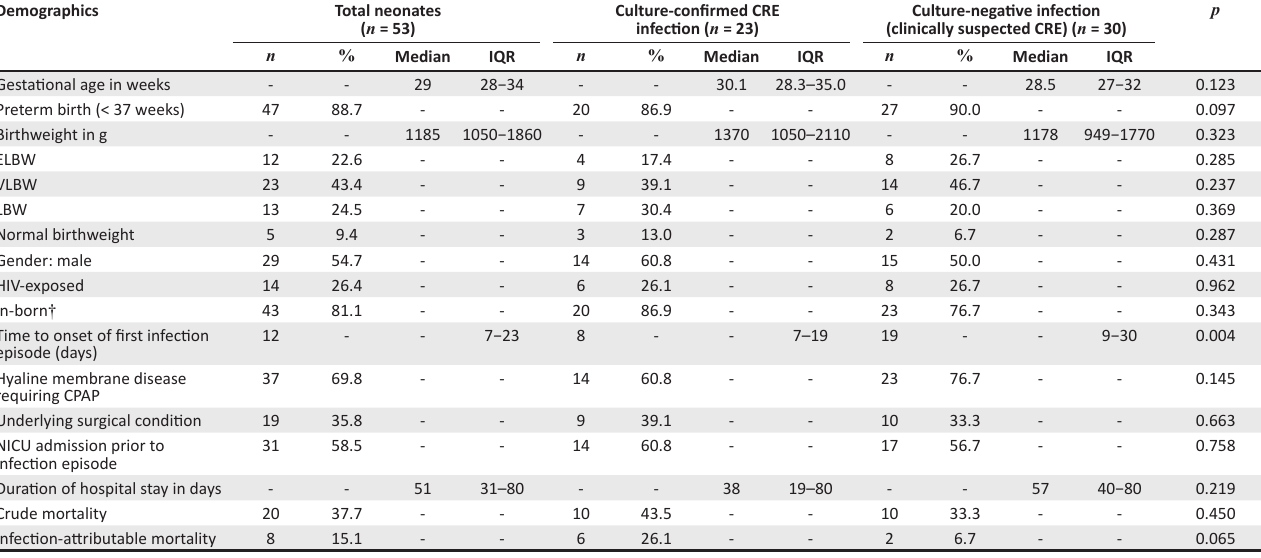
TABLE 1: Demographics of neonates with culture-confirmed carbapenem-resistant Enterobacterales infection and culture-negative infection (clinically suspected carbapenem-resistant) ( n = 53). Demographics Total neonates Culture-confirmed CRE ( n = 53) infection ( n = 23)